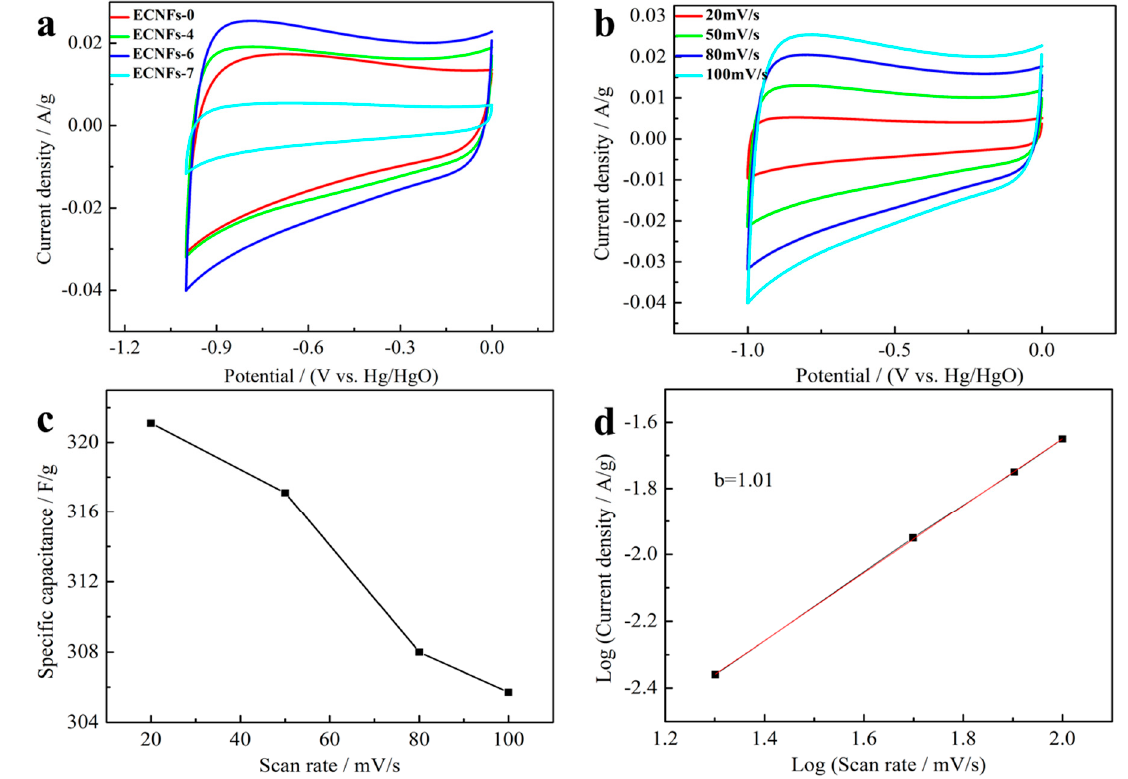
Figure 6. ( a ) CV curves at 100 mV/s; ( b ) CV curves of ECNFs-6 at different scan rates; ( c ) Rate performance of ECNFs-6; and ( d ) b-value was determined by fitting a log (discharge current density)–log (scan rate) plot.